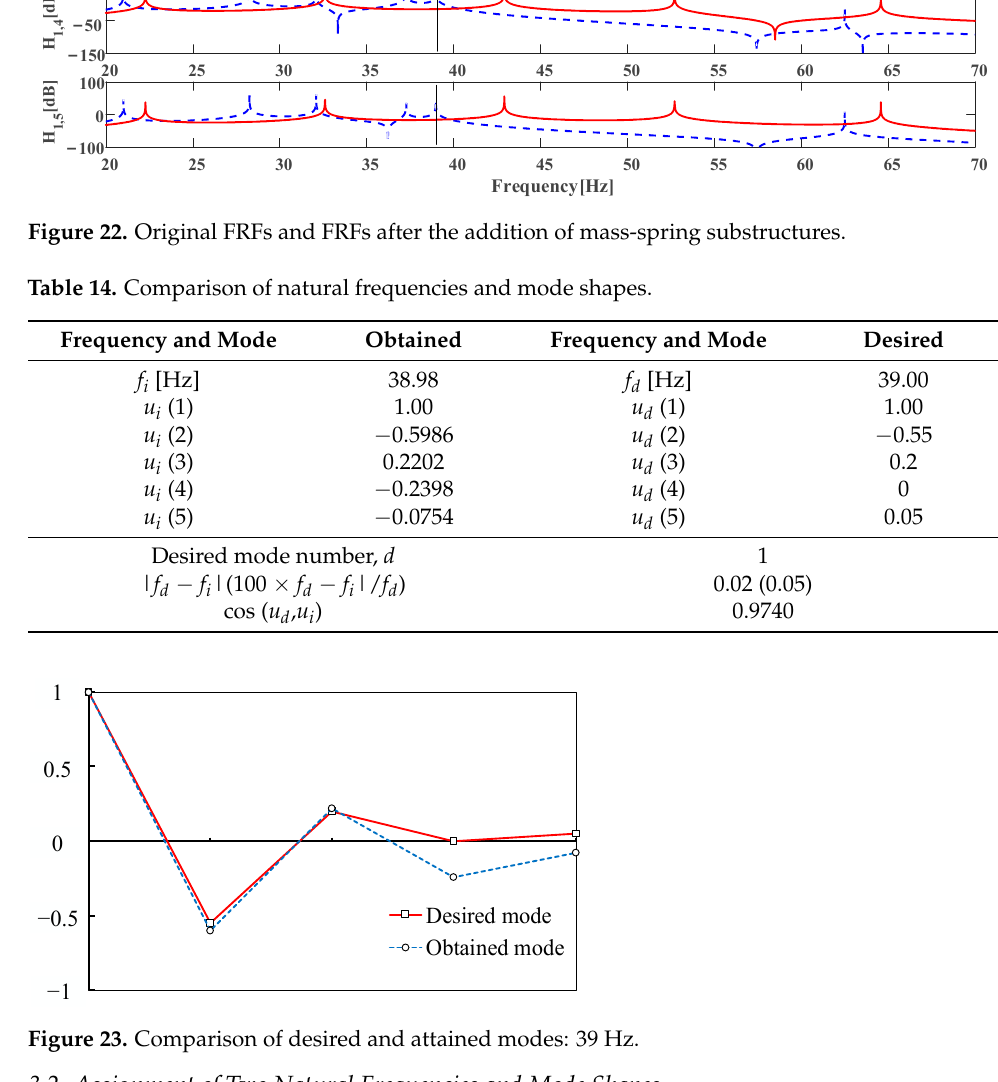
19 of 29 Figure 21. Modified structure after the addition of spring-mass substructures. Table 13. Parameters of added masses and stiffness of the substructures. Mass (kg)